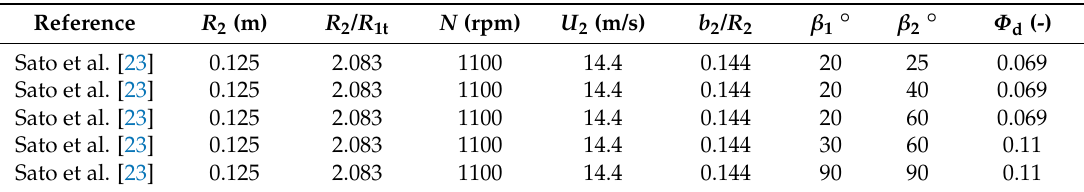
Table 3. Reference list on blade angle